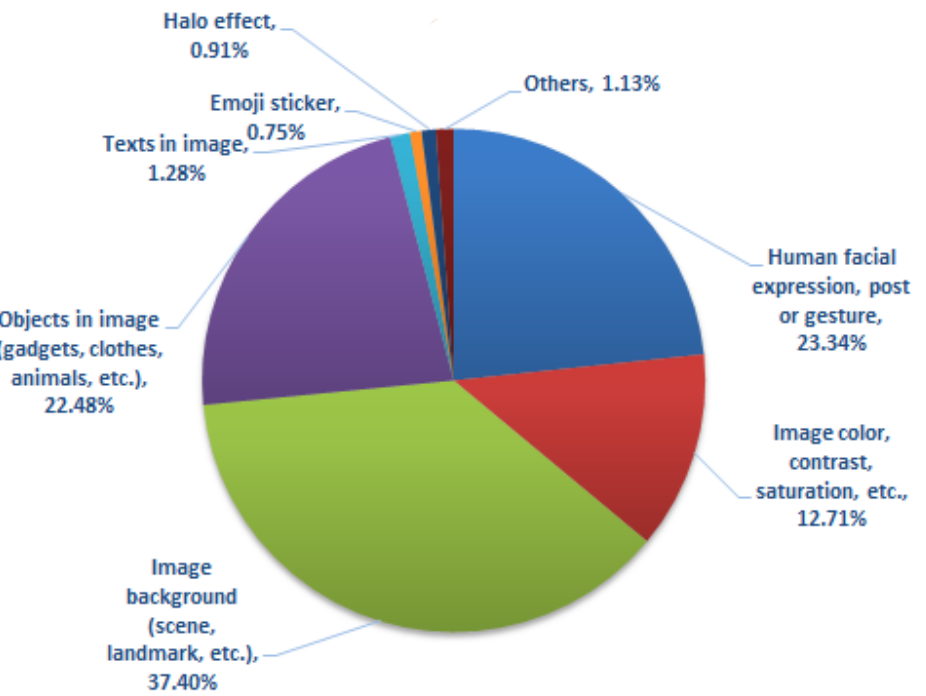
Figure 5. Statistics of the fifth question of the crowd-sourcing study in terms of what kind of information in the images influence users’ emotion